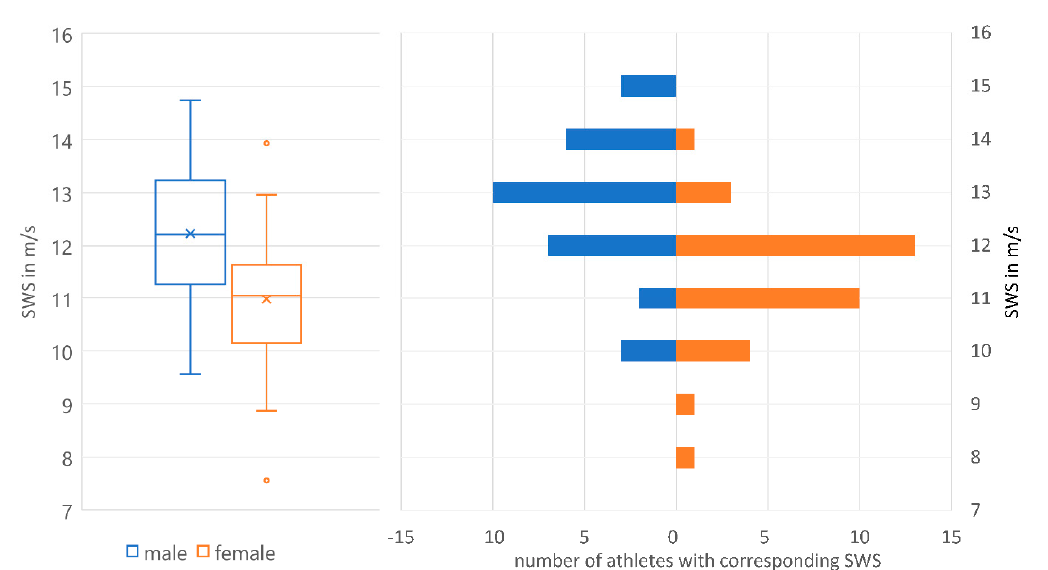
Figure 2. SWS in m/s of Achilles tendon in professional athletes (male = blue, female = orange). Table 2. Multiple linear regression model of AT sti ff ness in professional athletes.